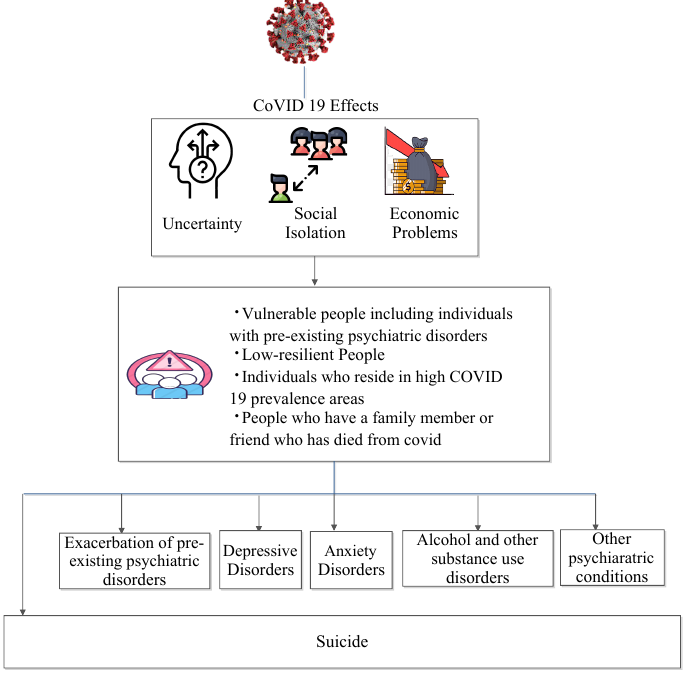
Figure 6. Psychological factors driving the increase in suicides due to COVID-19